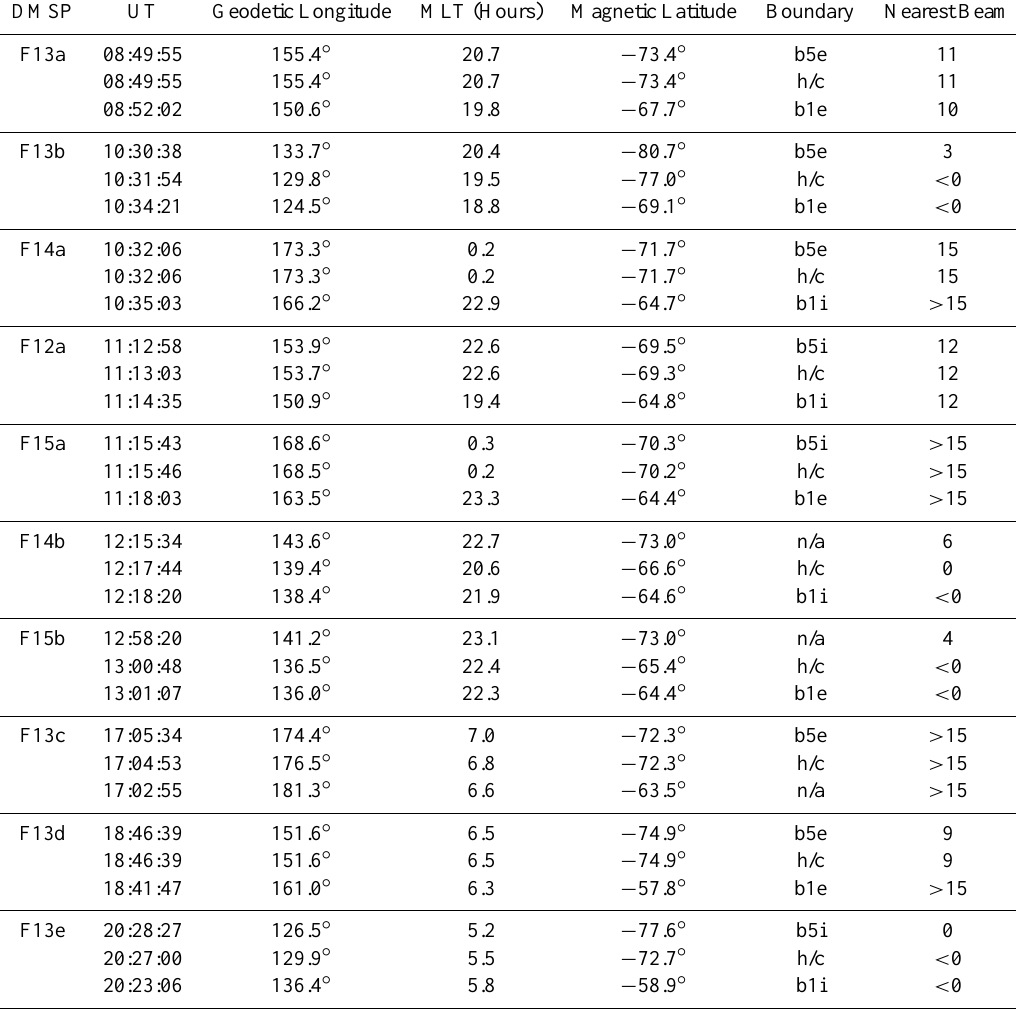
Table 1. Nightside auroral oval boundaries superimposed in Fig.